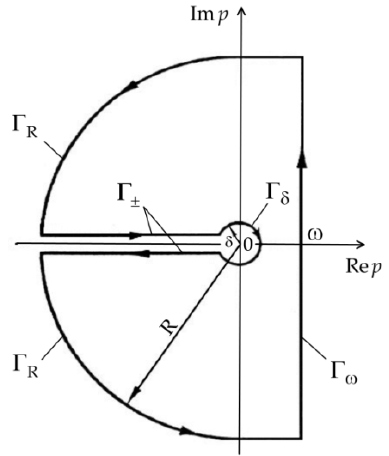
Figure 2. Integration contour Γ .